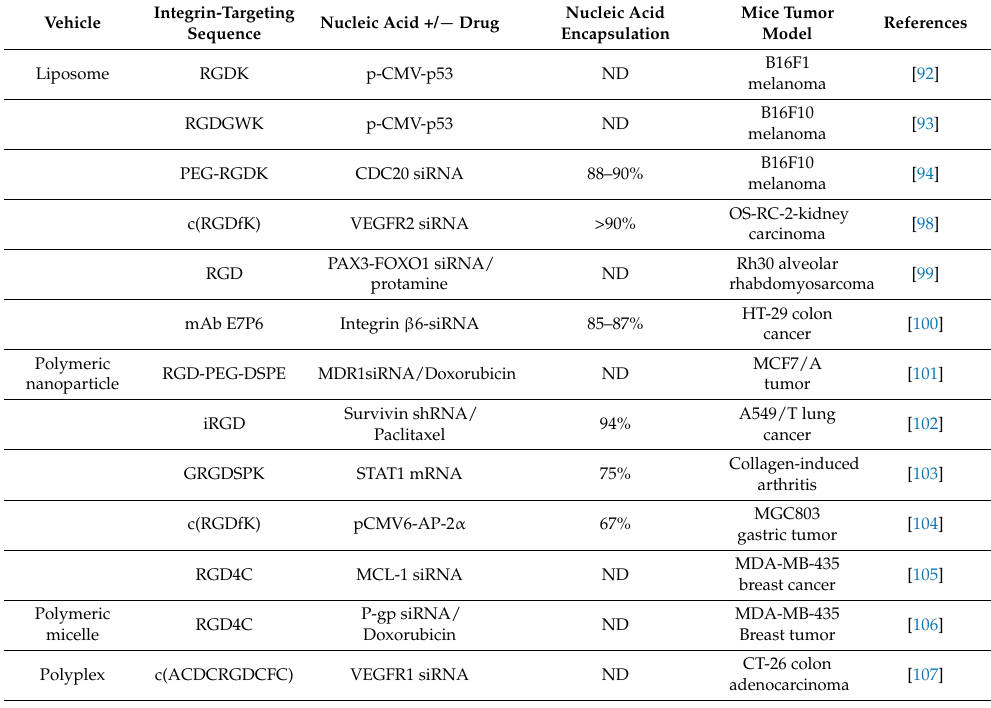
Table 2. A non-exhaustive list of integrin-receptor mediated nucleic acid delivery